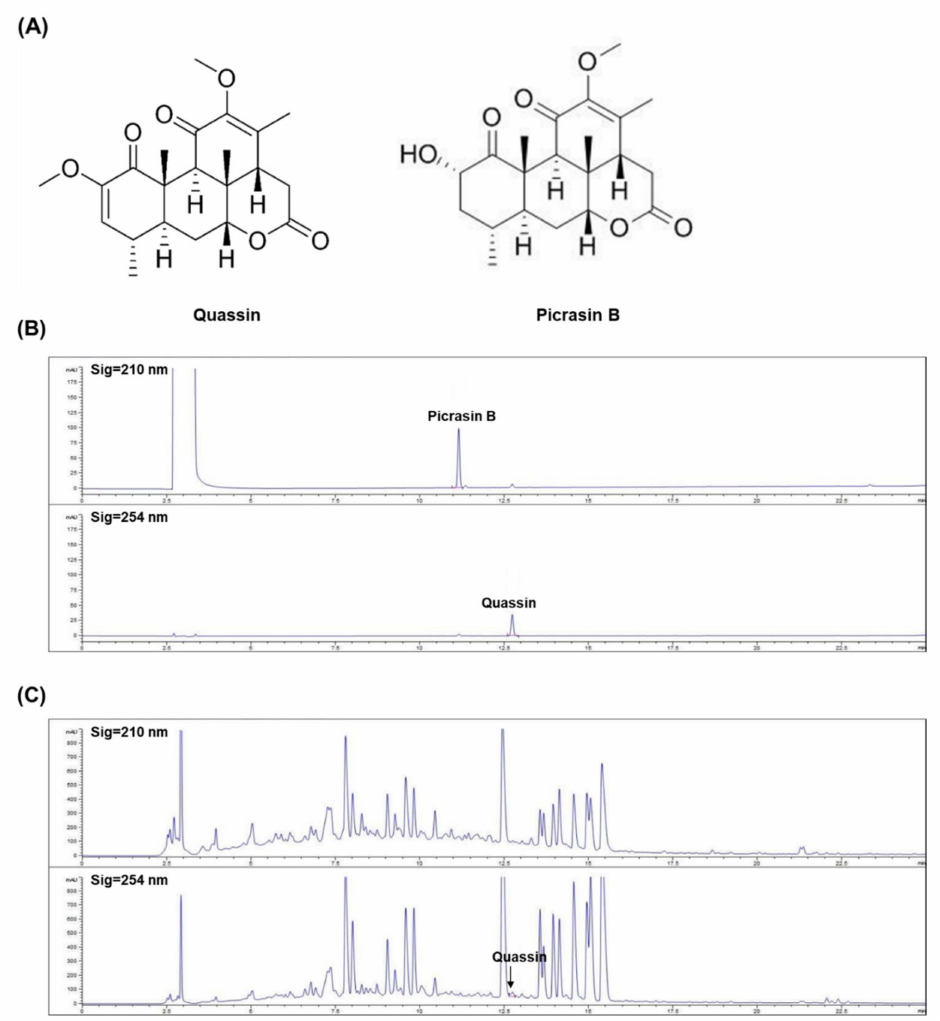
Figure 7. Analysis of chemical constituents of GMP by HPLC. ( A ) Structures of picrasin B and quassin. HPLC chromatograms of the standard compounds ( B ) and GMP ( C